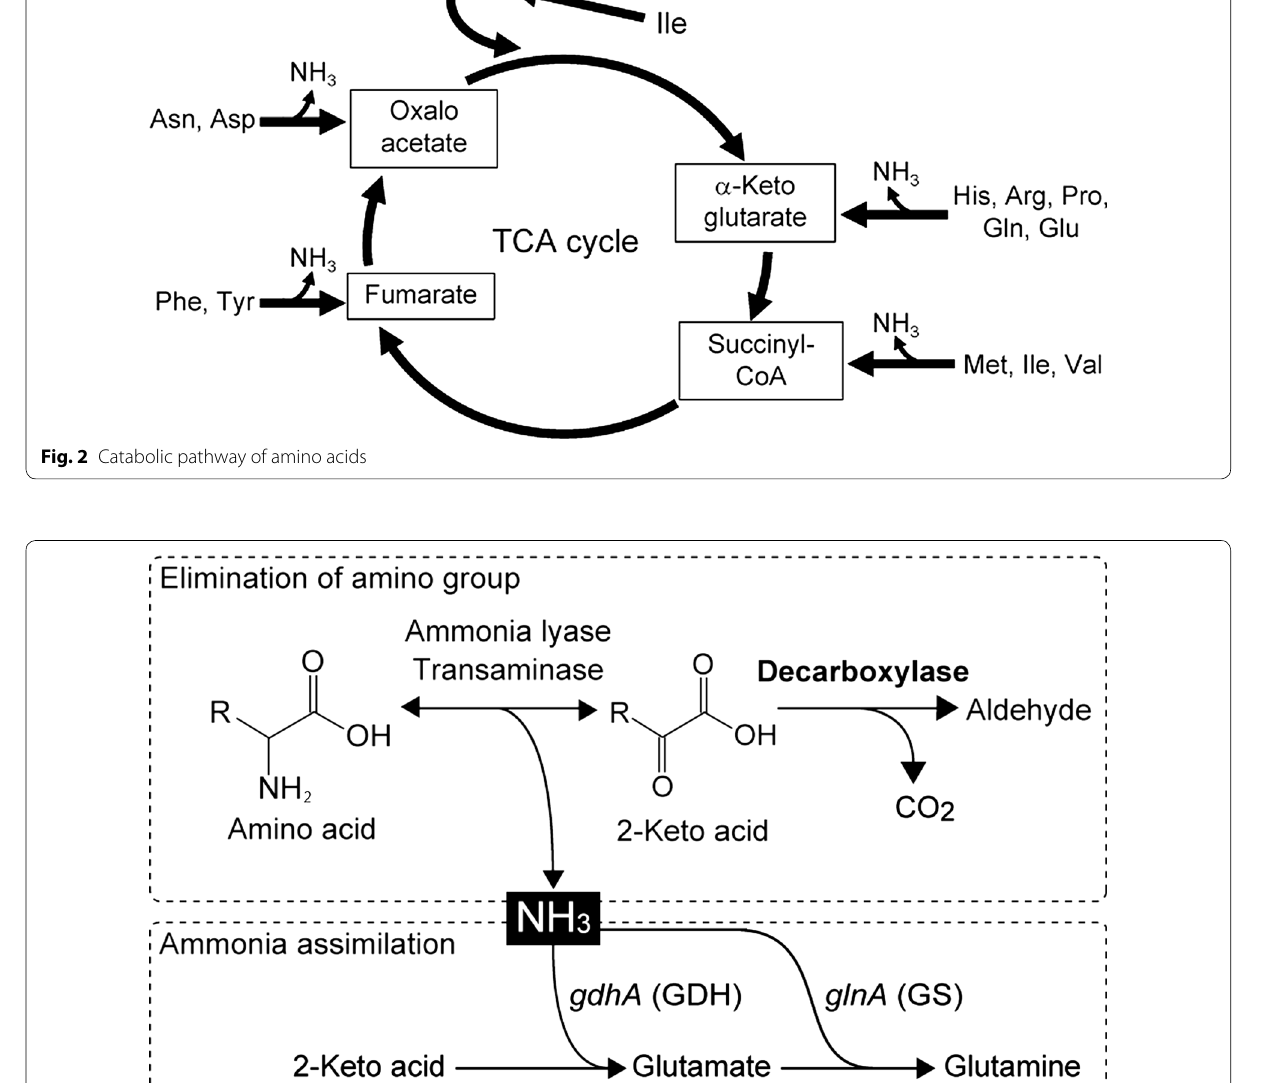
Deletion of glnA (Δ glnA ) or gdhA blocks ammonia re- uptake and lead to secretion of ammonia into the media.